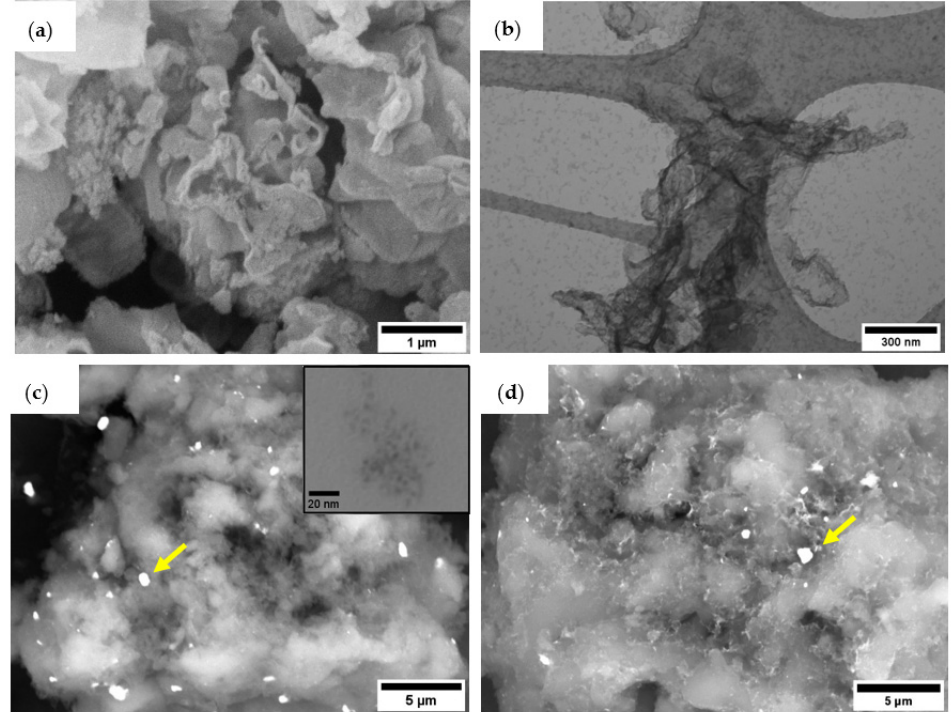
Cs 3 Bi 2 Br 9 NCs.